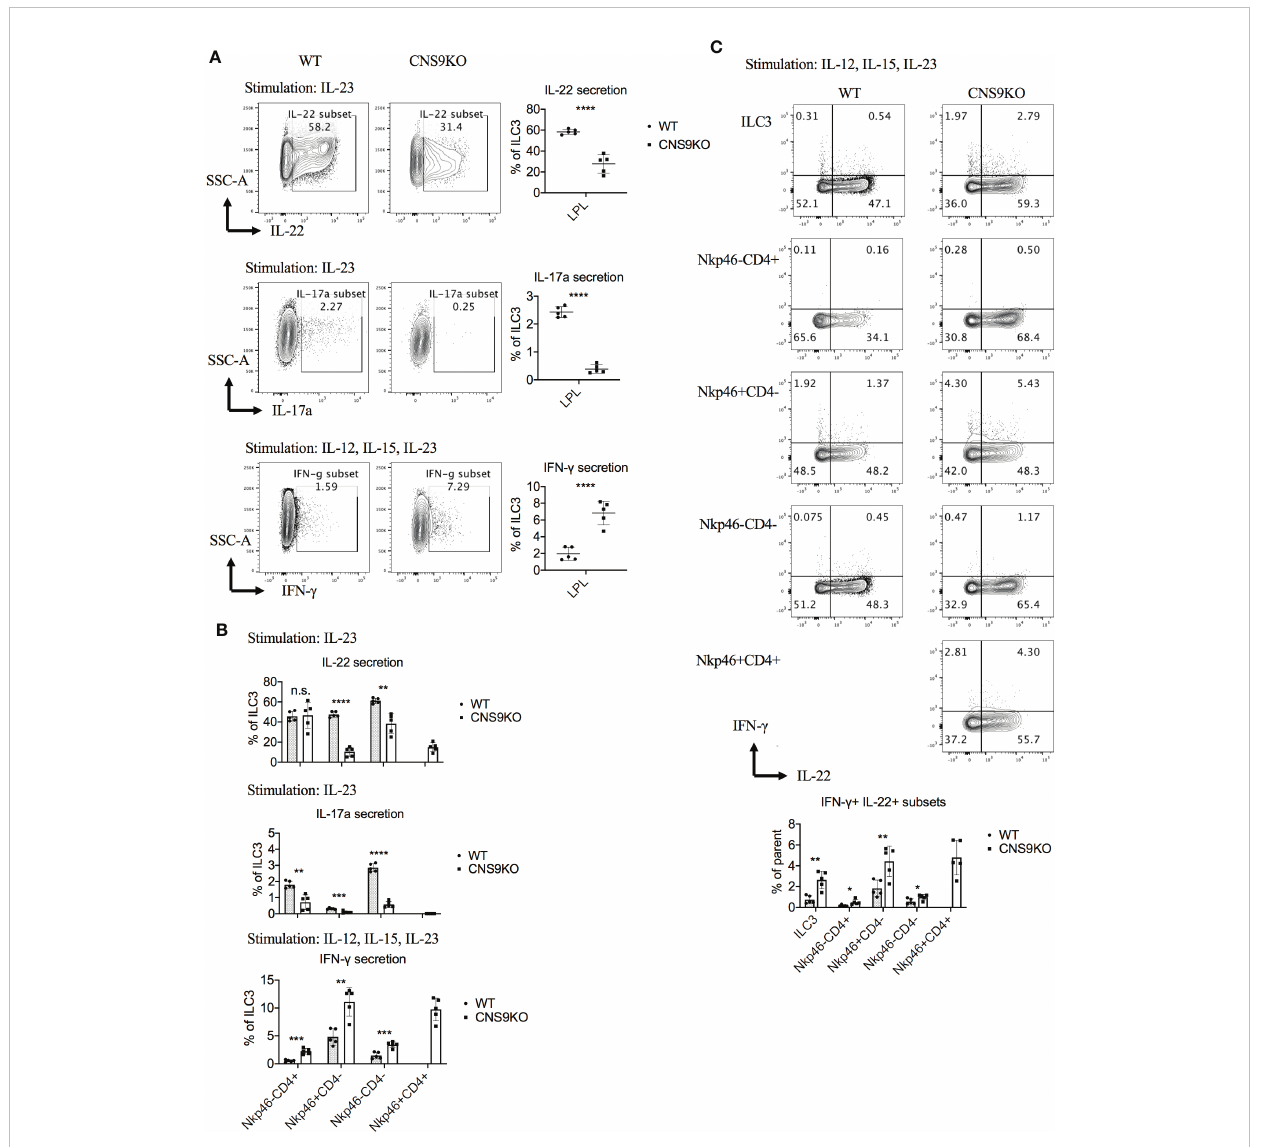
FIGURE 2 CNS9 de fi ciency modulates the cytokine production of ILC3s. ILC3s were isolated from the small intestine lamina propria lymphocytes (LPLs) of age- and sex-matched WT and CNS9-de fi cient mice under steady state. Stimulated ex vivo for 4 hours before staining with surface markers, ROR g t and cytokines, and then analyzed by fl ow cytometry. (A) Left: intracellular staining of IL-22, IL-17A and IFN- g single positive cells in total ILC3s; right: statistic of the staining data. (B) Statistic analysis of IL-22, IL-17A and IFN- g in different ILC3 subsets. (C) Up: intracellular staining of IL-22 and IFN- g ; down: statistic analysis of IL-22 + IFN- g + double positive cells in total ILC3s and different subsets. The data shown are a representative of two to three independent experiments and presented as mean ± SD. Also see Figure S2. Statistical signi fi cance wascalculated using unpaired Student ’ s t test and shown as *p < 0.05; **p < 0.01; ***p < 0.001, ****p < 0.0001 or n.s. (non-signi fi cant) p >